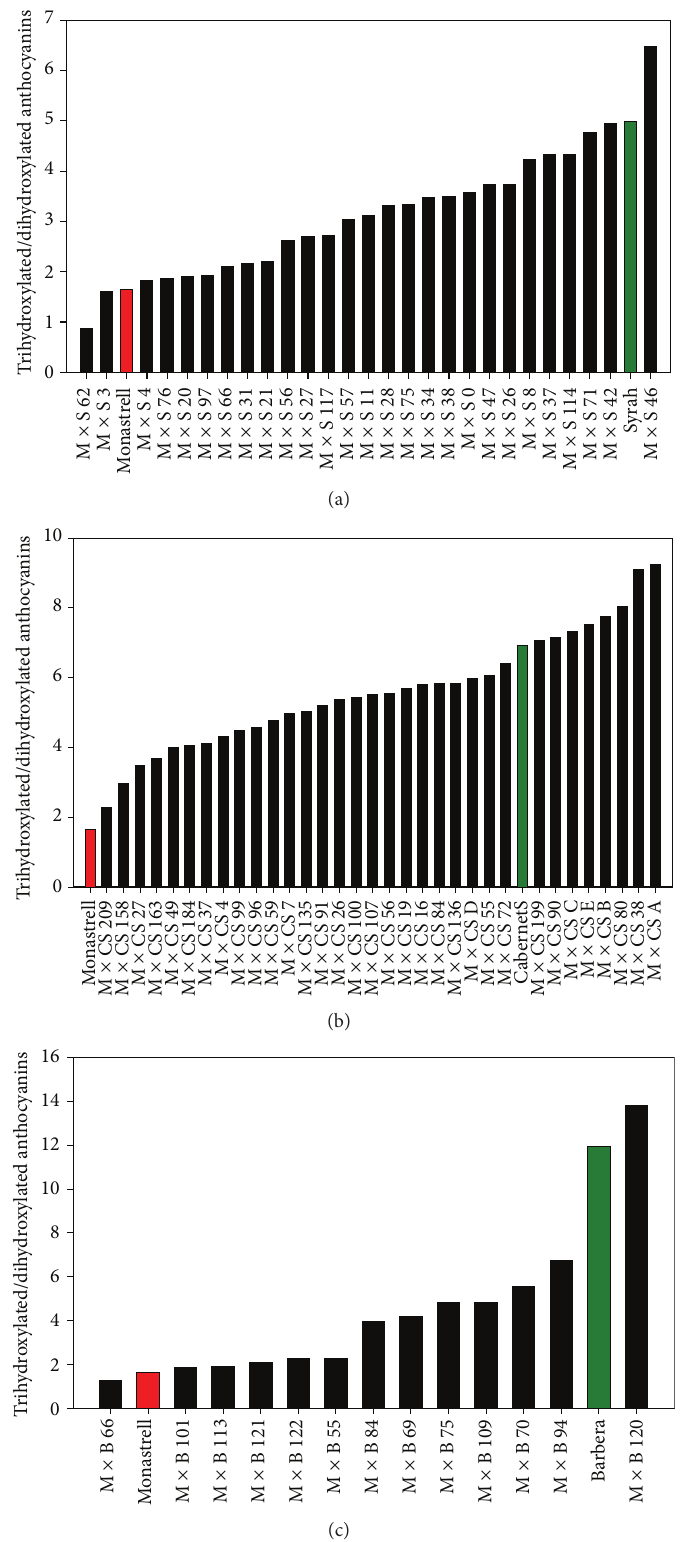
Figure 3: Trihydroxylated/dihydroxylated anthocyanins ratios in Monastrell × Syrah (a), Monastrell × Cabernet Sauvignon (b), and Monastrell × Barbera (c) hybrid